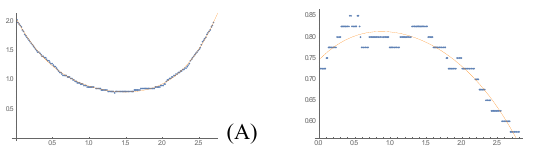
Fig. 3. Edge detection and curve fitting of the anterior surface of the lens unaccommodated (A) and accommodated (B).